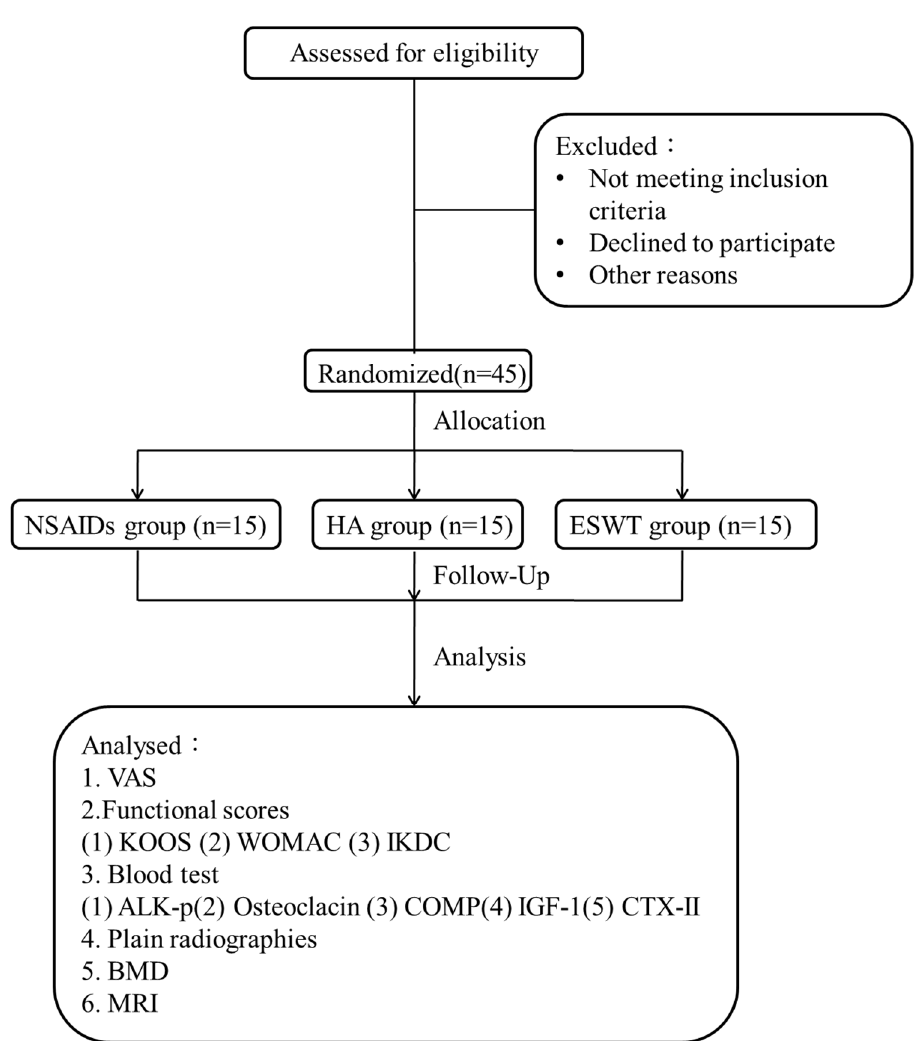
Figure 1. CONSORT flow diagram. NSAIDs, non-steroid anti-inflammatory drugs. HA, hyaluronic acid. ESWT, extracorporeal shockwave therapy. VAS, visual analogue scale. KOOS, knee injury and osteoarthritis outcome. WOMAC, Western Ontario and McMaster Universities Arthritis